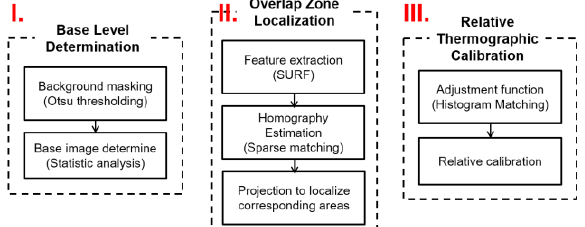
Figure 3: Overview of our relative thermographic calibration method